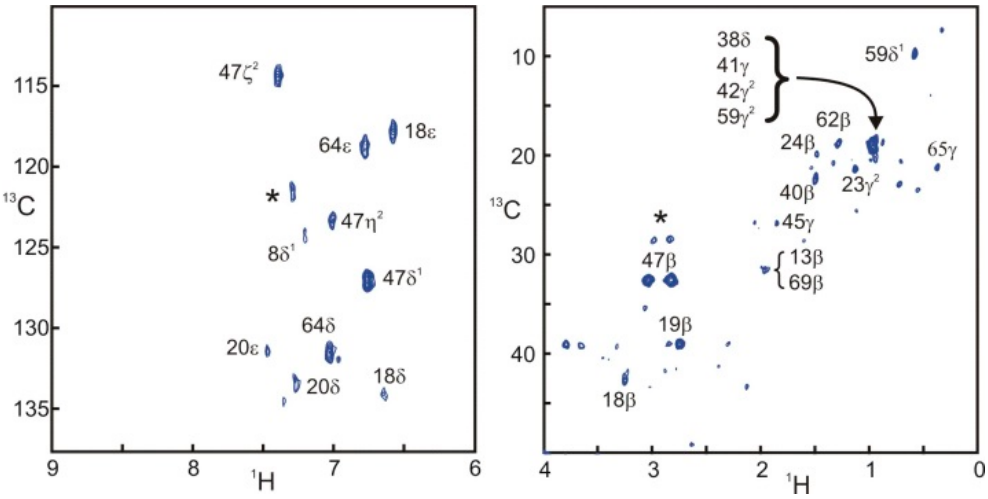
Figure 4. Selective saturation transfer difference 1 H{ 13 C}HSQC spectra of the aromatic and aliphatic side-chains in SH3. Both spectra were obtained with the sequence and parameters presented in Figure 1. Assignments appear directly on the spectra. When several peaks overlap, all assigned resonances appear adjacent to a brace. Stars (*) correspond to unassigned resonances.